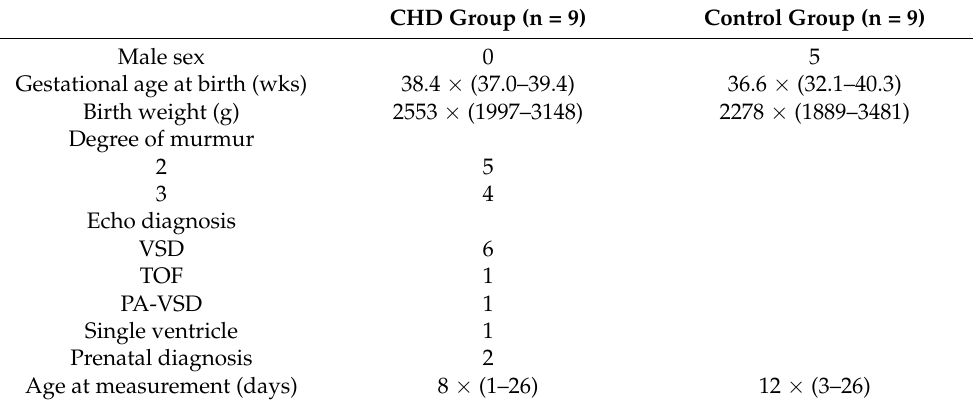
Table 1. Clinical characteristics of